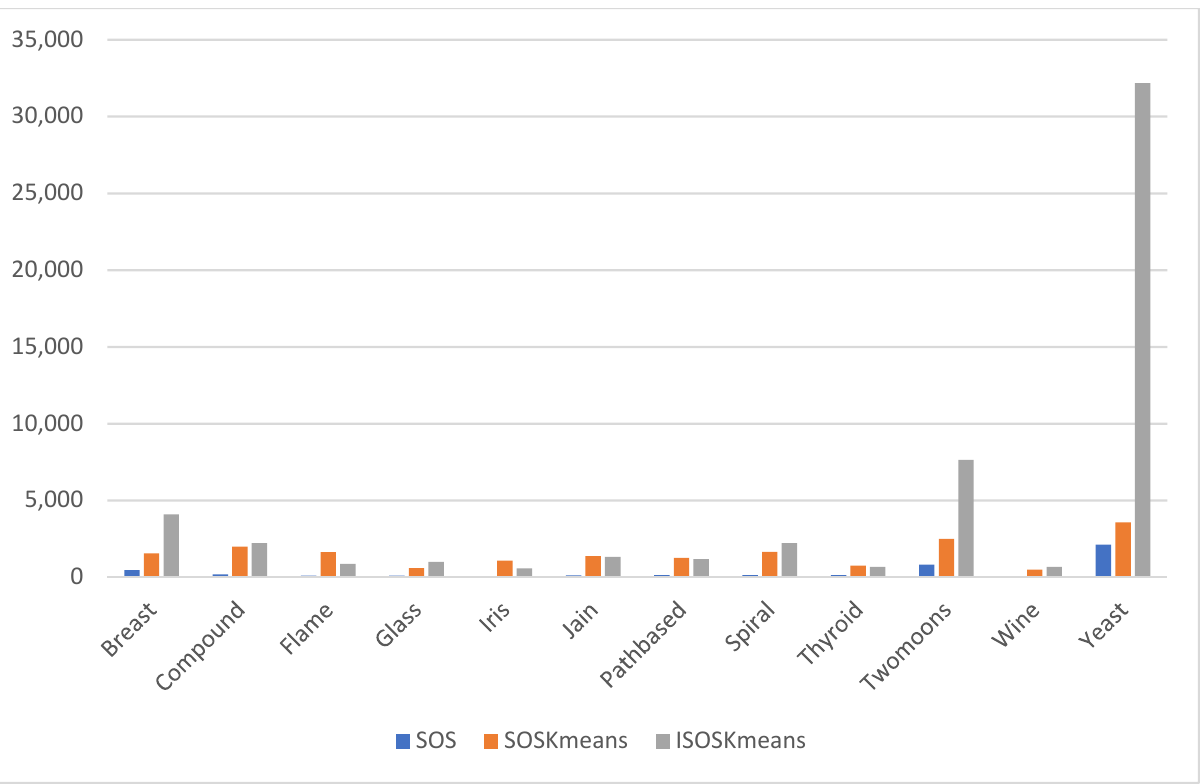
Figure 6. Analysis of computational times of SOS, SOSK-means and ISOSK-means under the DB index.